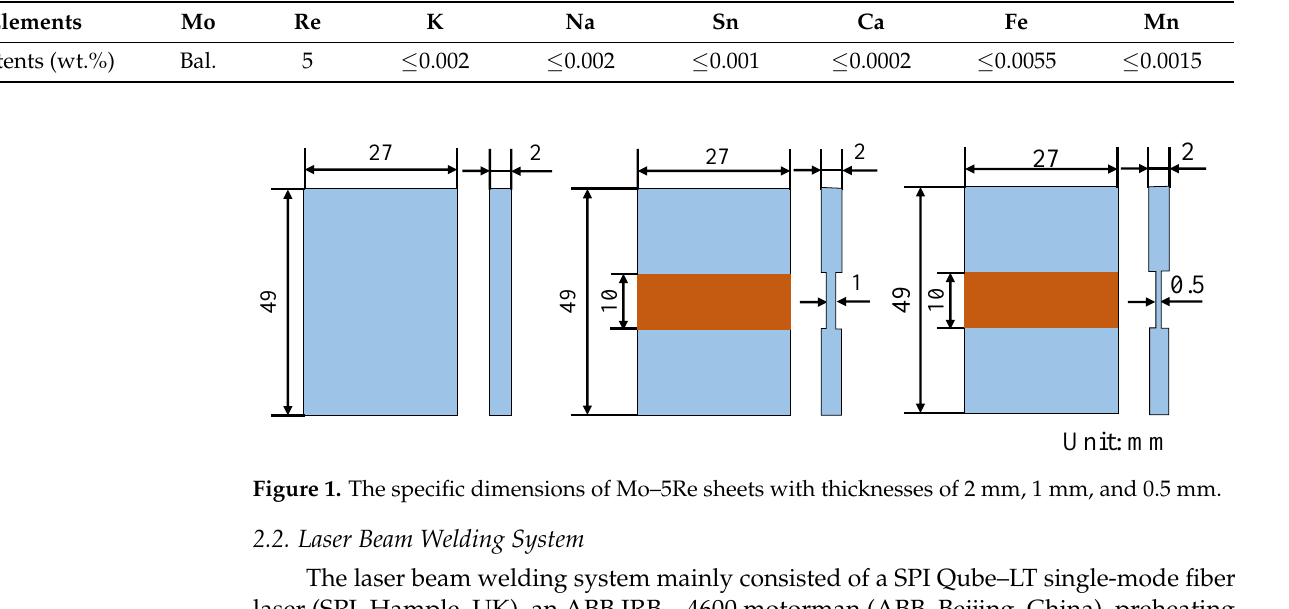
Table 1. Relative contents of various elements in the Mo–5Re sheets.